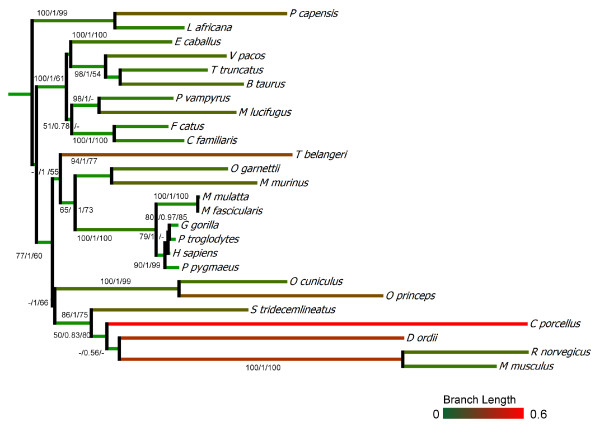
Phylogenetic tree of MEPE. Depiction of MEPE protein phylogeny constructed using Bayesian inference (Bayes), Maximum Likelihood (ML) and Neighbor-Joining (NJ) algorithms. Support for each node is summarized on the branch prior to the node (ML/Bayes/NJ). For the NJ and ML analysis the bootstrap values < 50 are represented with the symbol (-). Branches are shaded with a gradient based on the branch length, from green (short) to red (longer).